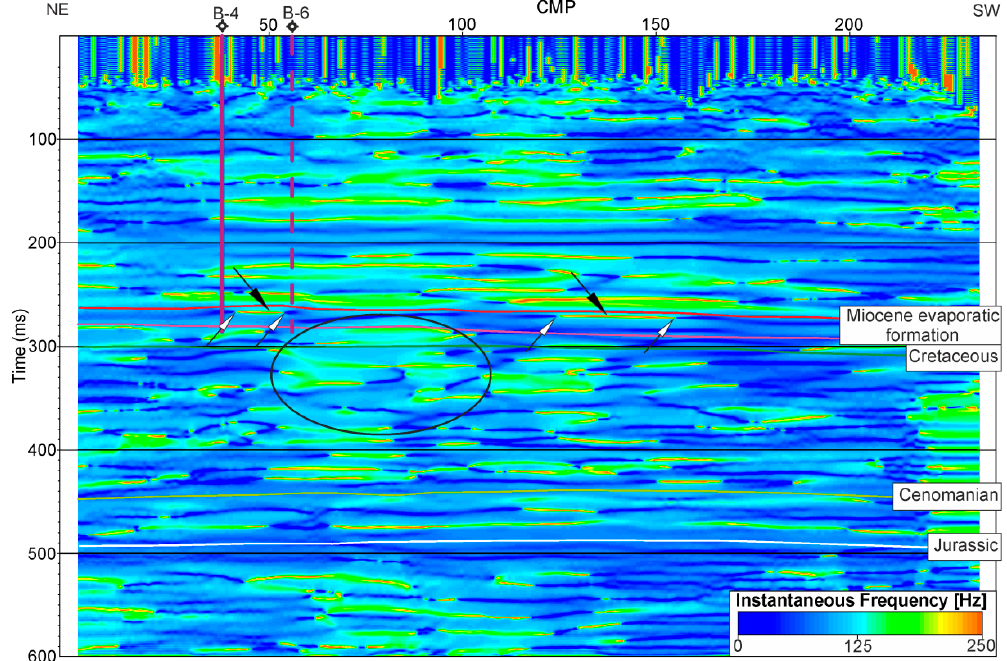
Figure 8. Seismic profile 2 in instantaneous frequency attribute with interpretation and wells position. Well B-6 is projected from 25 m. Black arrows indicate thin beds, white arrows indicate places where thin beds lose their thickness. In the area marked by an ellipse, tuning can occur.